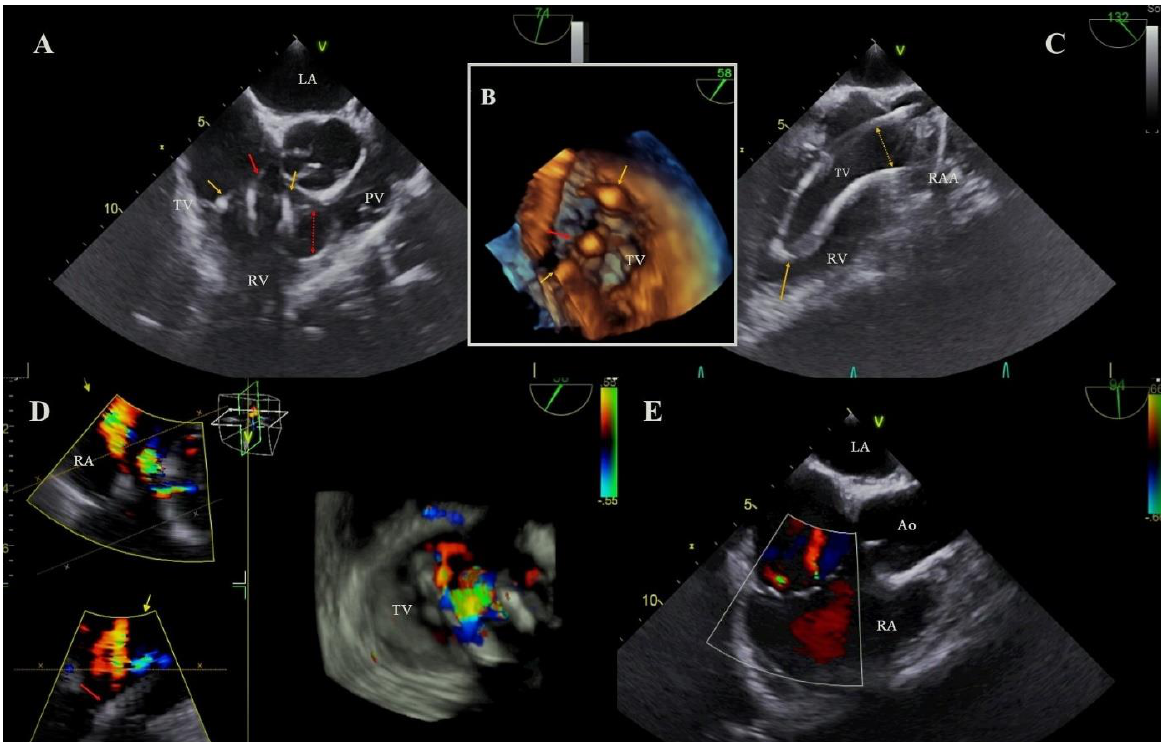
Figure 1. The excessive loop of the lead as a reason of LDTVD. ( A ): The loop of the atrial lead in the tricuspid valve (TV), entering the right ventricular (RV) lumen (yellow arrows). A ventricular lead through the TV forms a loop in the right ventricular outflow tract RVOT (red arrows). TEE 2D. ( B ): Three leads visible in the tricuspid valve, atrial loop of the lead distributed in the commissures (yellow arrows), centrally located ventricular lead (red arrow). TEE 3D. ( C ): After removal of the ventricular lead (TLE), the atrial lead loop was clearly visible. TEE 2D. ( D ): Two jets of a significant tricuspid regurgitation (TR) to the right atrium resulting from the collision of the three leads with the valve leaflets. TEE 3D color doppler. ( E ): The effect after TLE procedure. Two jets of non-significant tricuspid regurgitation remained. TEE 2D.